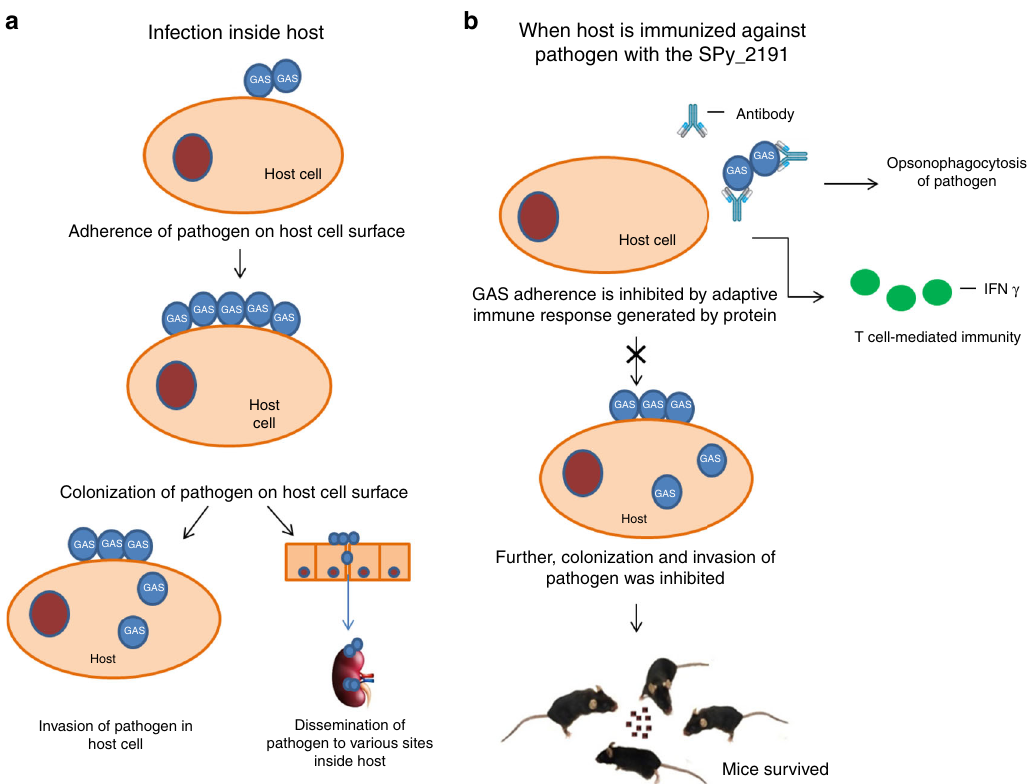
Fig. 6 Adhesion and invasion of GAS in placebo and SPy_2191-vaccinated mice. a Graphical representation of how GAS infects a host by fi rst adhering then colonizing on the host cell surface, later invades and disseminates inside the cell. b In SPy_2191-vaccinated mice, GAS infection was bypassed plausibly due to the presence of bactericidal antibodies that caused opsonophagocytosis, thus blocking adhesion of bacteria on the host cell surface and subsequently hindered colonization and invasion of GAS within the host. Further a Th1-biased immune response and immuno-stimulation triggered by SPy_2191 helps the mice to survive against GAS challenge ’